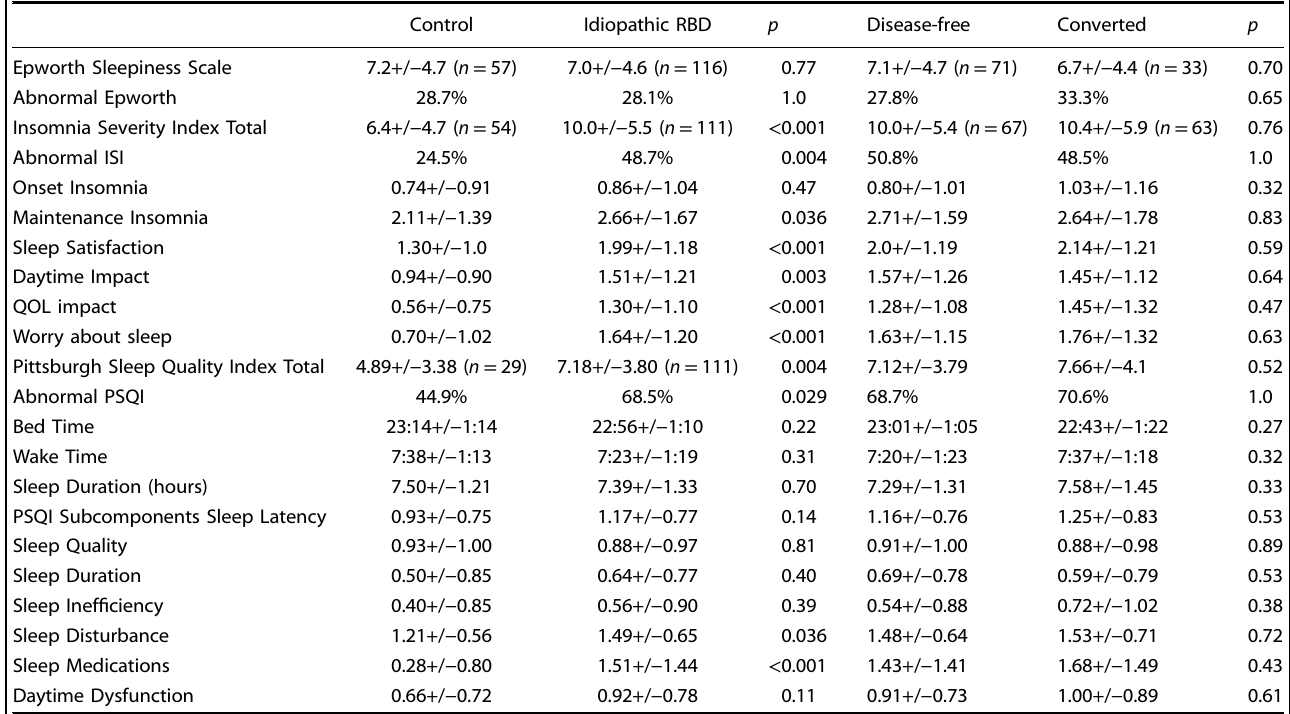
Table 1. Baseline sleep scale scores